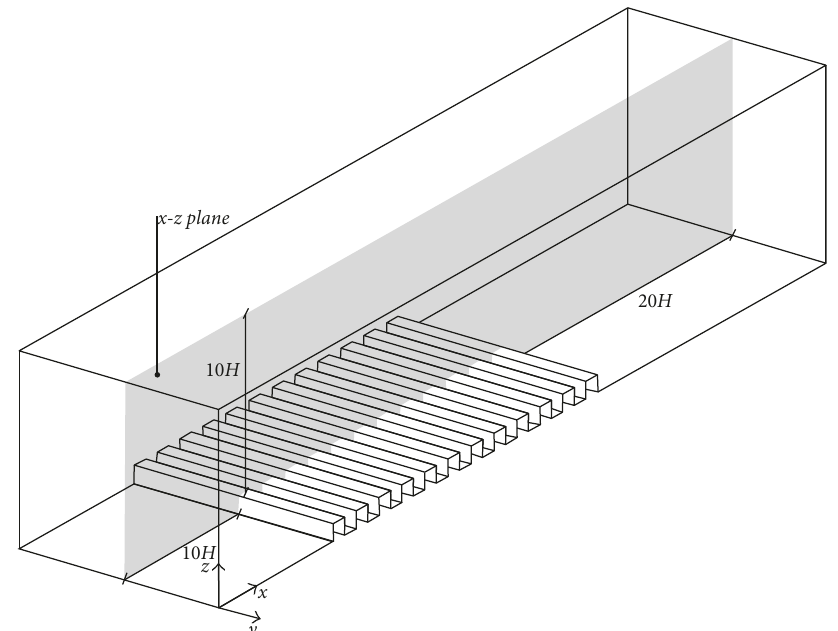
Figure 3: The computational domain for the 3D simulation. H indicates the building height.